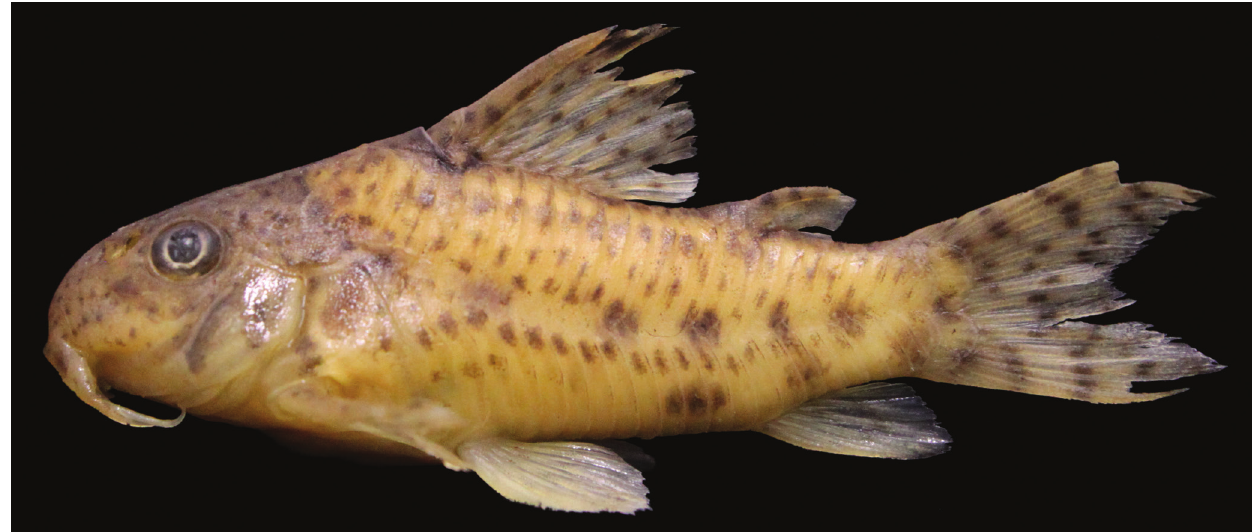
Fig. 4. Lateral view of Corydoras flaveolus , LBP 14596, 31.6 mm SL, showing general shape of the body and color patter in lateral